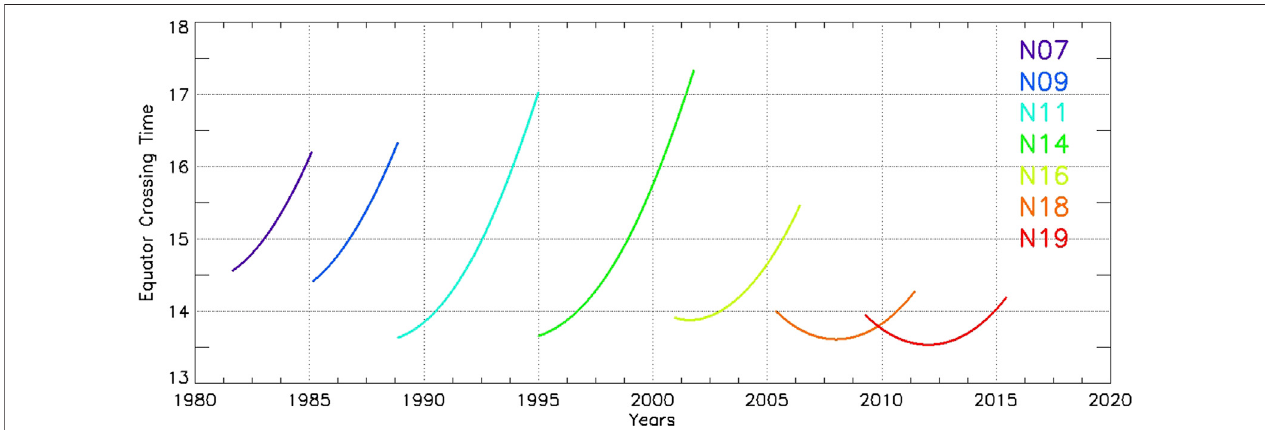
FIGURE 1 | Equatorial crossing times for the NOAA afternoon platforms simulated in this